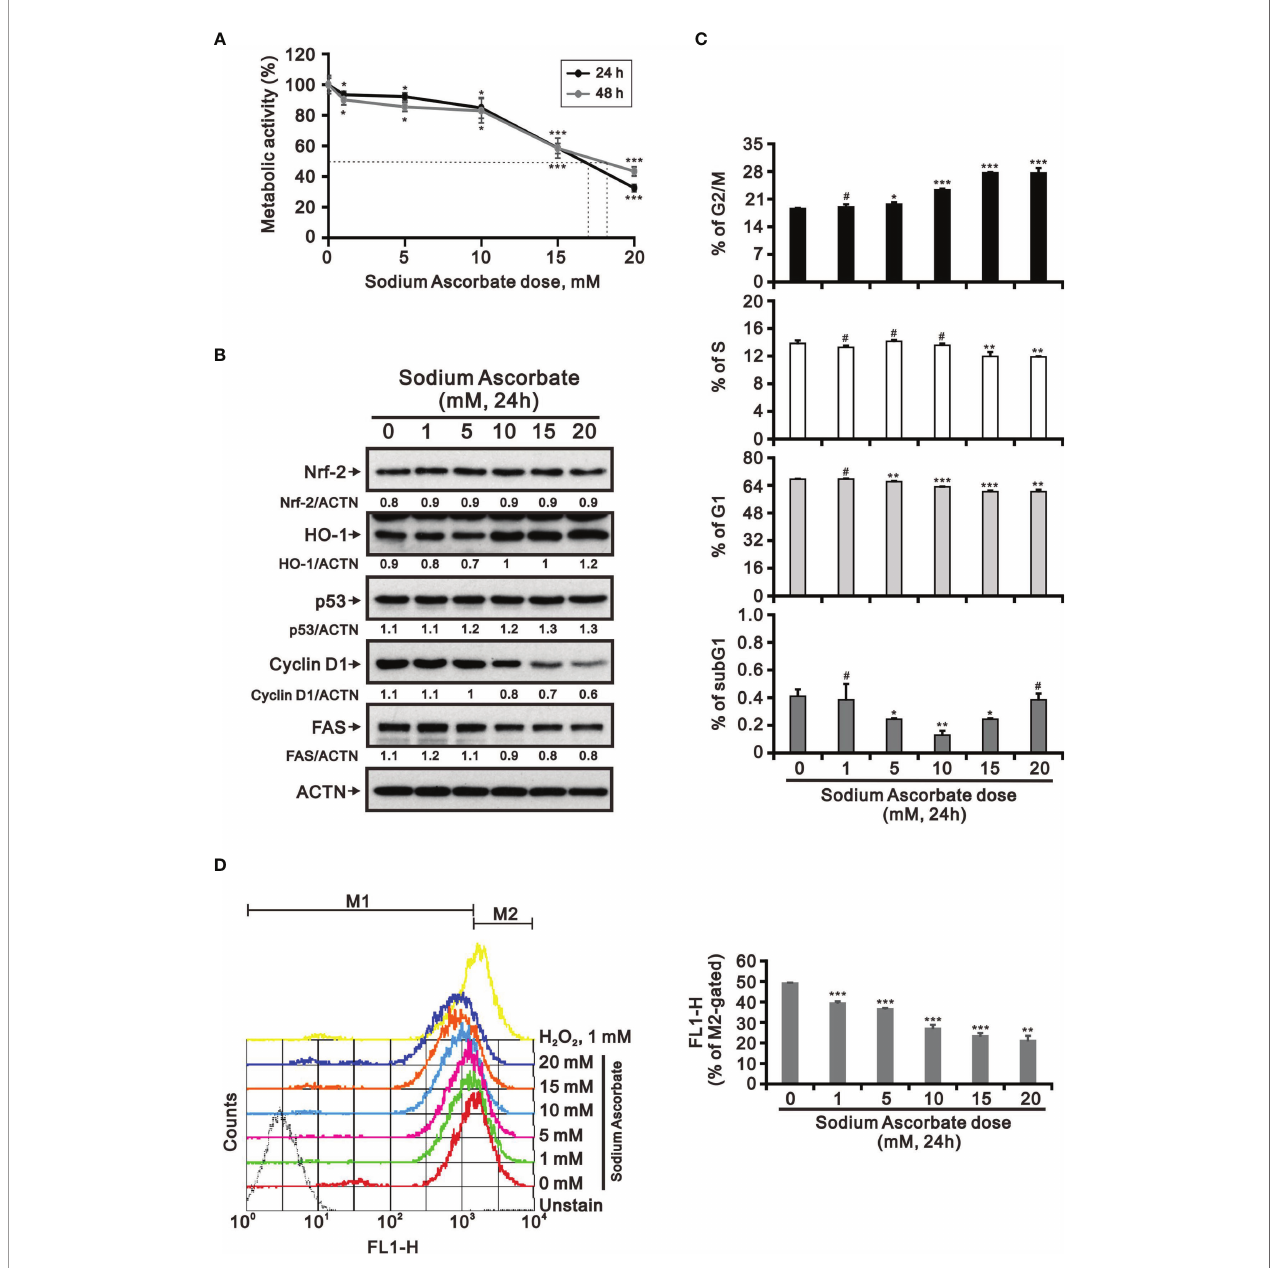
FIGURE 2 | Effects of sodium ascorbate on cell metabolic activity in HepG2 cells. (A) HepG2 cells were treated for 24 h or 48 h with the indicated concentrations of sodium ascorbate. Cell metabolic activity was measured using the MTT assay. HepG2 cells were treated with the indicated concentrations of sodium ascorbate for 24 h, after which their cell lysates were subjected to (B) Western blot analysis using antibodies against the indicated proteins (ACTN was the protein loading control), (C) cell-cycle pro fi ling using fl ow cytometry analysis, and (D) ROS status determination using 10 m M DCFH-DA. The cell volume gating strategy involved FSC-H and SSC-H, and the median fl uorescence intensity of the vehicle was used as the starting point for M2 gating. Protein bands were quanti fi ed through pixel density scanning and evaluated using ImageJ, version 1.44a (http://imagej.nih.gov/ij/). We show one representative result. Bars depict the mean ± SD of three independent experiments. # p > 0.05, * p < 0.05, ** p < 0.01, and *** p < 0.001 compared with the vehicle (Student ’ s